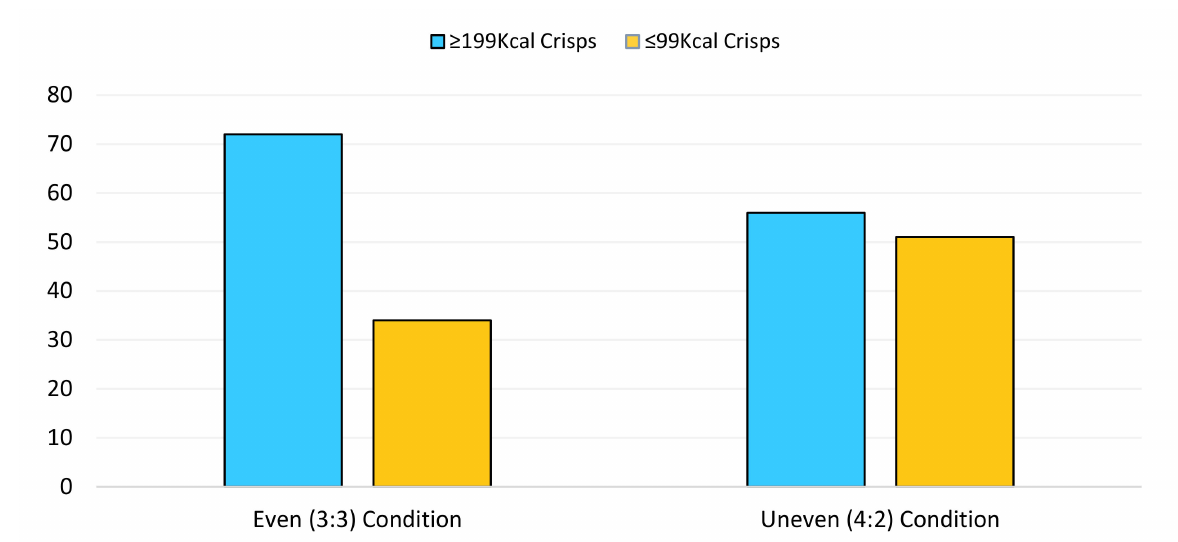
Figure 3. The number of 99 kcal (depicted in orange) and 199 kcal (presented in blue) crisp selections made across the even (3:3 availability) and uneven conditions (4:2 availability in favour of the 99